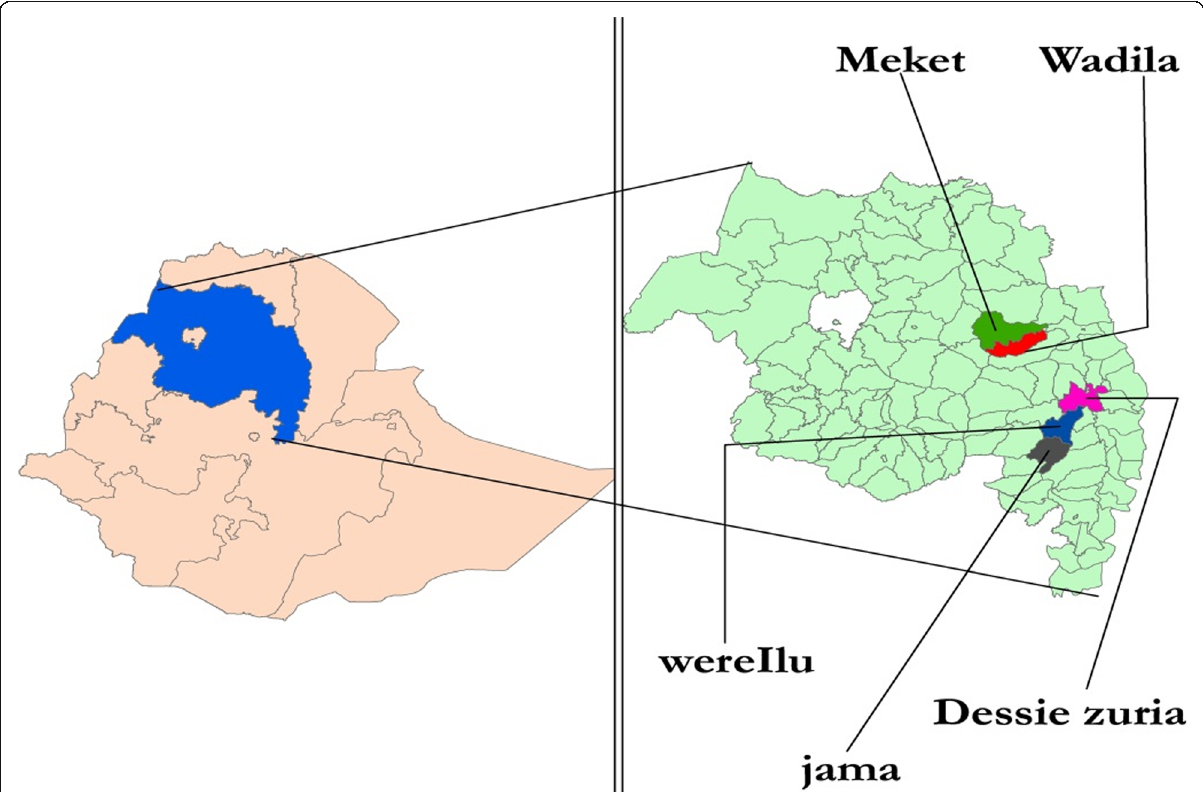
Fig. 1 Map of Ethiopia showing the study